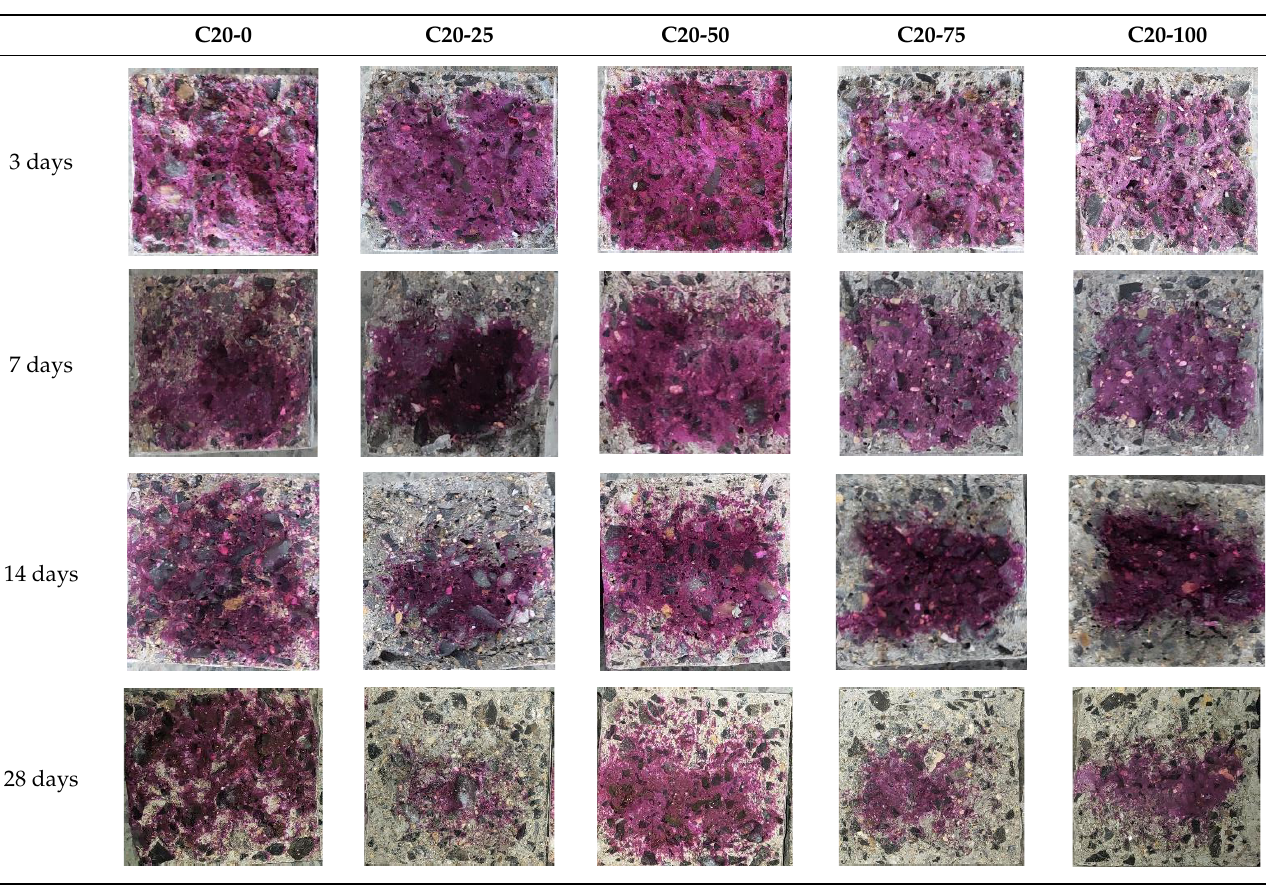
Figure 18. Carbonization depth of C20 concrete.